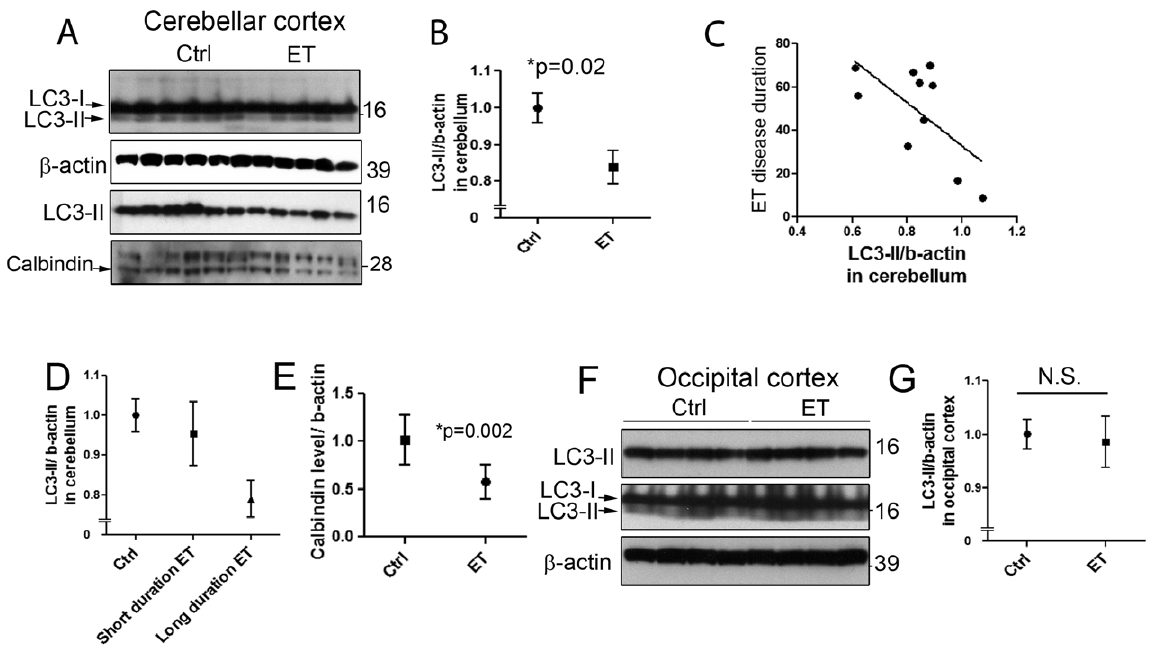
Figure 1. Decreased LC3-II levels in the cerebellum of essential tremor (ET) cases and controls. LC3-II and b -actin levels in cerebellar homogenates were determined by Western blot in 10 ET cases and 11 controls. Two LC3 antibodies were used, LC3 antibody, Novus Biologicals 1384 (top panel), and LC3-II specific antibody Novus Biologicals 19167 (third panel) and the representative bands were shown (A). LC3-II levels (mean 6 SD) were significantly lower in ET cases vs. controls (B). In a linear regression model, ET disease duration inversely correlated with LC3-II level (C).When dividing our sample into three categories, ET cases with the longest disease duration had the most diminished LC3-II levels, followed by ET cases with shorter duration disease and then controls (D). ET cases displayed lower levels of calbindin than age-matched controls, consistent with PC cell loss (A, E). We also determined the LC3-II and b -actin levels in the occipital cortex in 7 ET cases and 9 controls and the representative blots were shown (F). ET cases and controls exhibited similar LC3-II levels in the occipital cortex (mean 6 SD)